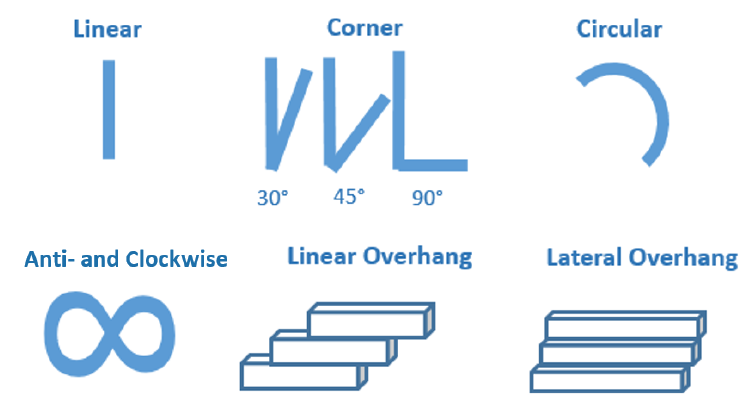
Figure 10. Experimental cases (paths) for